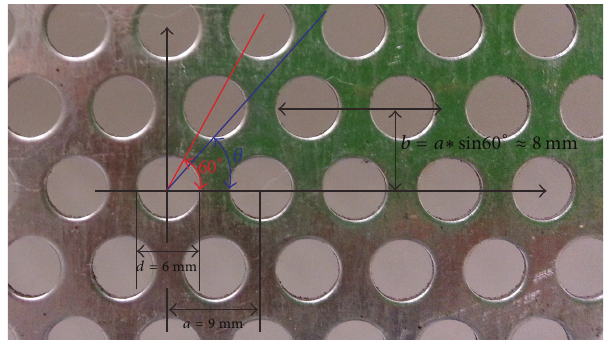
Figure 3: The prototype of the holed plate and the parameters of holes and relative positions.